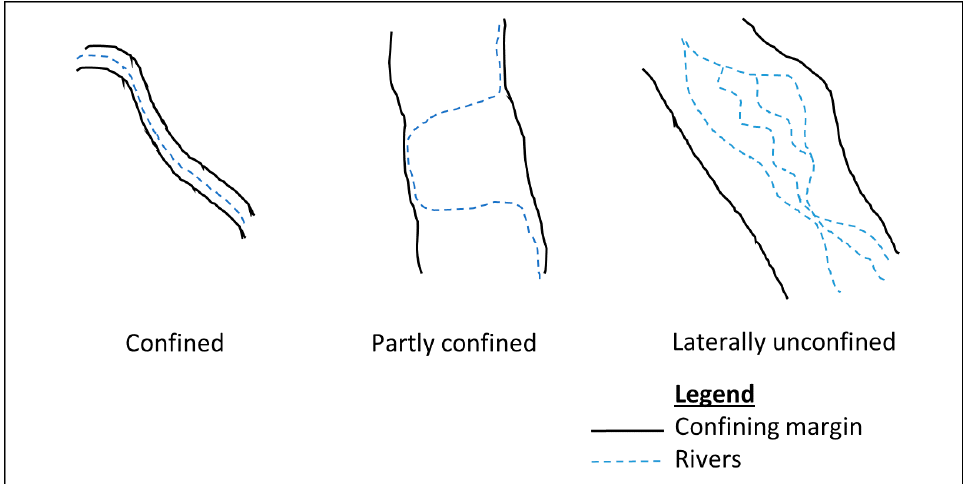
Figure 2. Different types of valley confinement modified from [10].